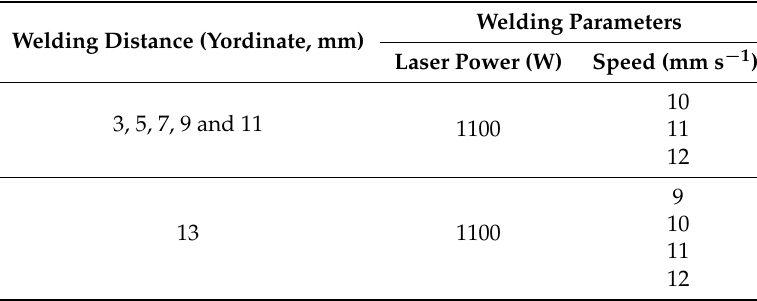
Table 2. Experimental